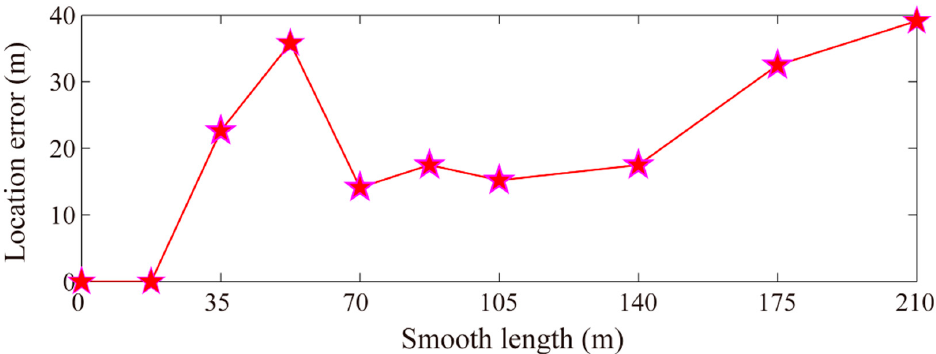
Figure 2. GSWI location errors under different velocity model smoothing scales for the blasting event 8.